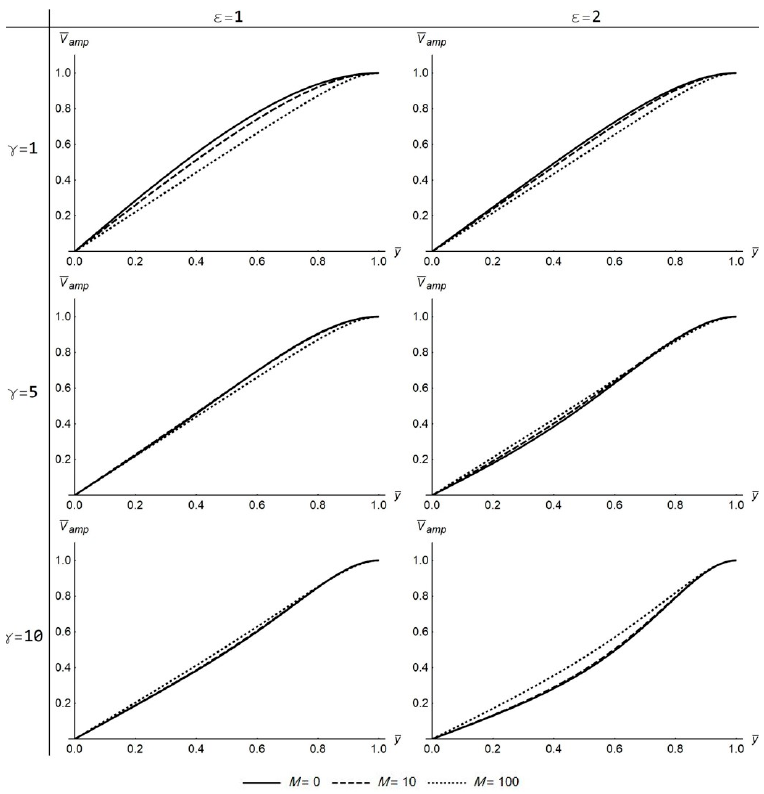
Figure 6. The profiles of V amp for different values of the ε , γ , and M parameters (transverse case). Figure 6. The profiles of 𝑉(cid:4636) (cid:3028)(cid:3040)(cid:3043) for different values of the 𝜀 , 𝛾,𝑎𝑛𝑑 𝑀 parameters (transverse case). Figure 6. The profiles of 𝑉(cid:4636) (cid:3028)(cid:3040)(cid:3043) for different values of the 𝜀 , 𝛾,𝑎𝑛𝑑 𝑀 parameters (transverse case).